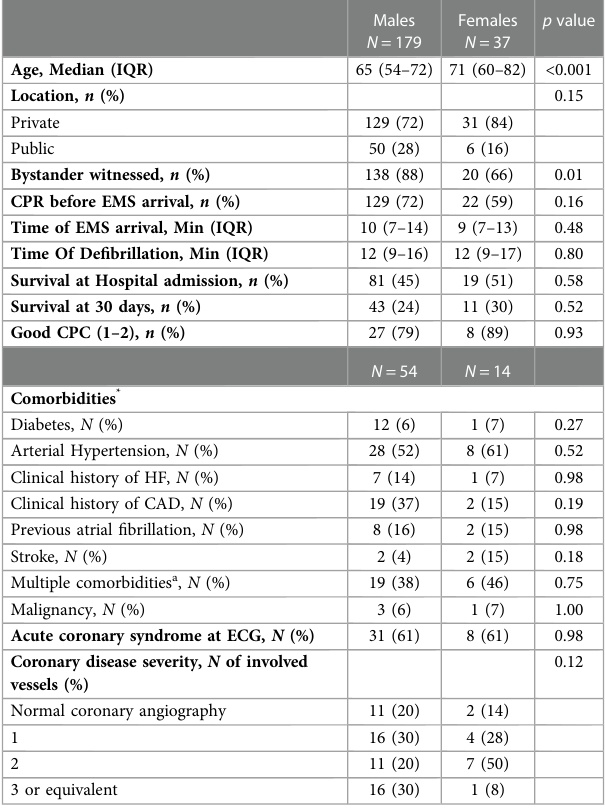
Table 4 reported differences in refractory vs. not refractory VA patients within the sex category. Male patients with refractory VA were signi fi cantly younger (65 [IQR 54 – 72] vs.